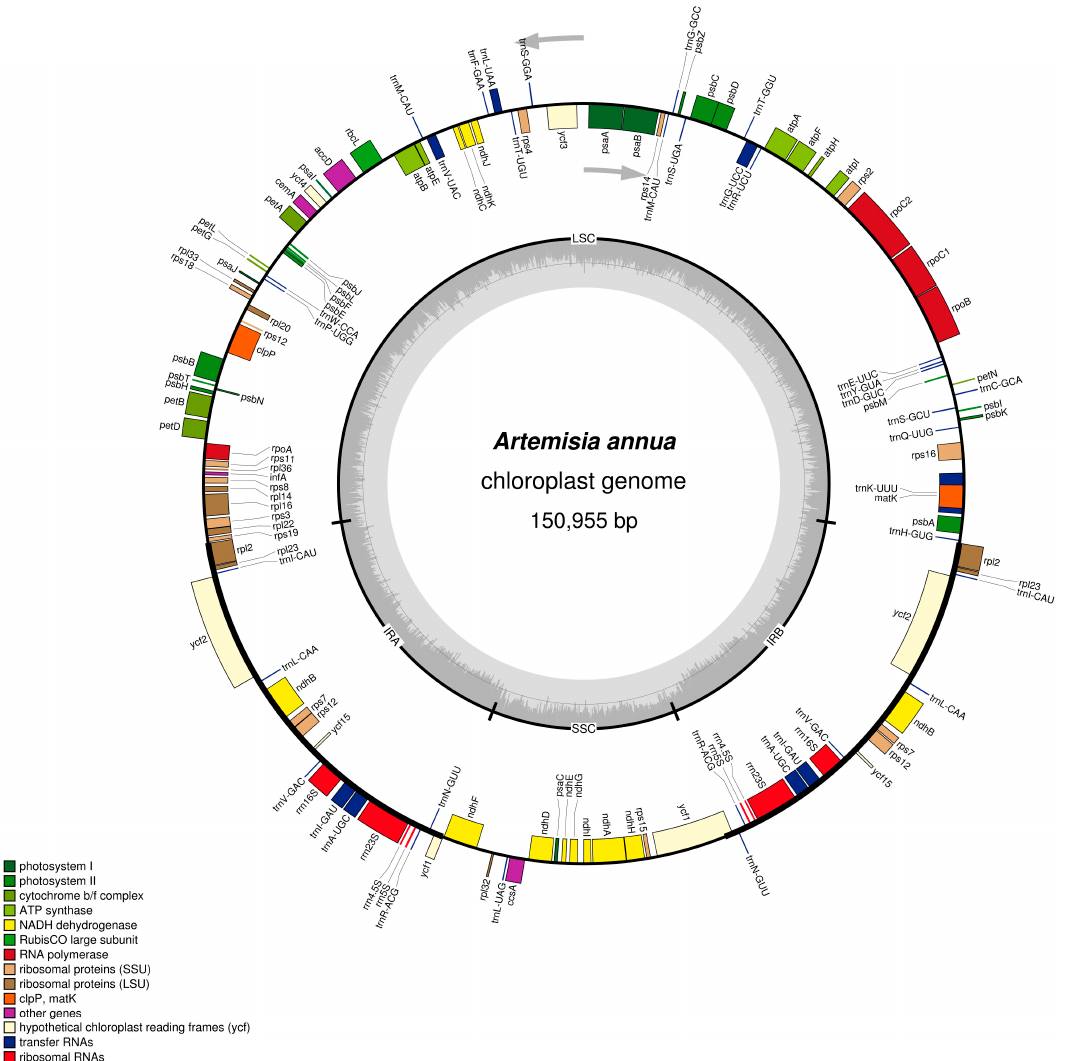
Figure 1. Gene map of the A. annua chloroplast genome. Genes drawn inside the circle are transcribed clockwise, and those outside are counterclockwise. Genes belonging to different functional groups are color-coded. The darker gray in the inner circle corresponds to GC content, while the lighter gray corresponds to AT content.